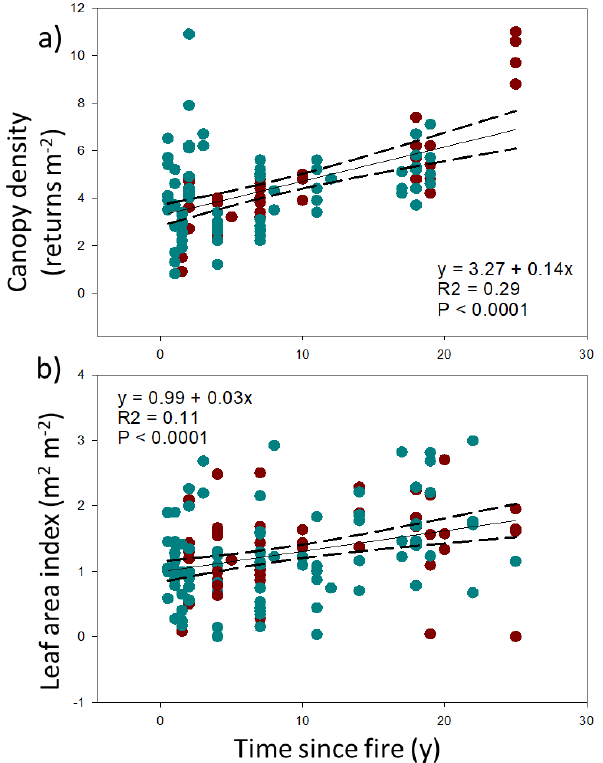
Figure 5. ( a ) Canopy density estimated from lidar surveys and ( b ) leaf area index both increased linearly over time since fire across the study area. These metrics met assumptions of normality and equal variance (Table 1); no interactions were found with Threatened Ecological Communities. Maroon, Ironbark Forest; Teal, Scribbly Gum Woodland.